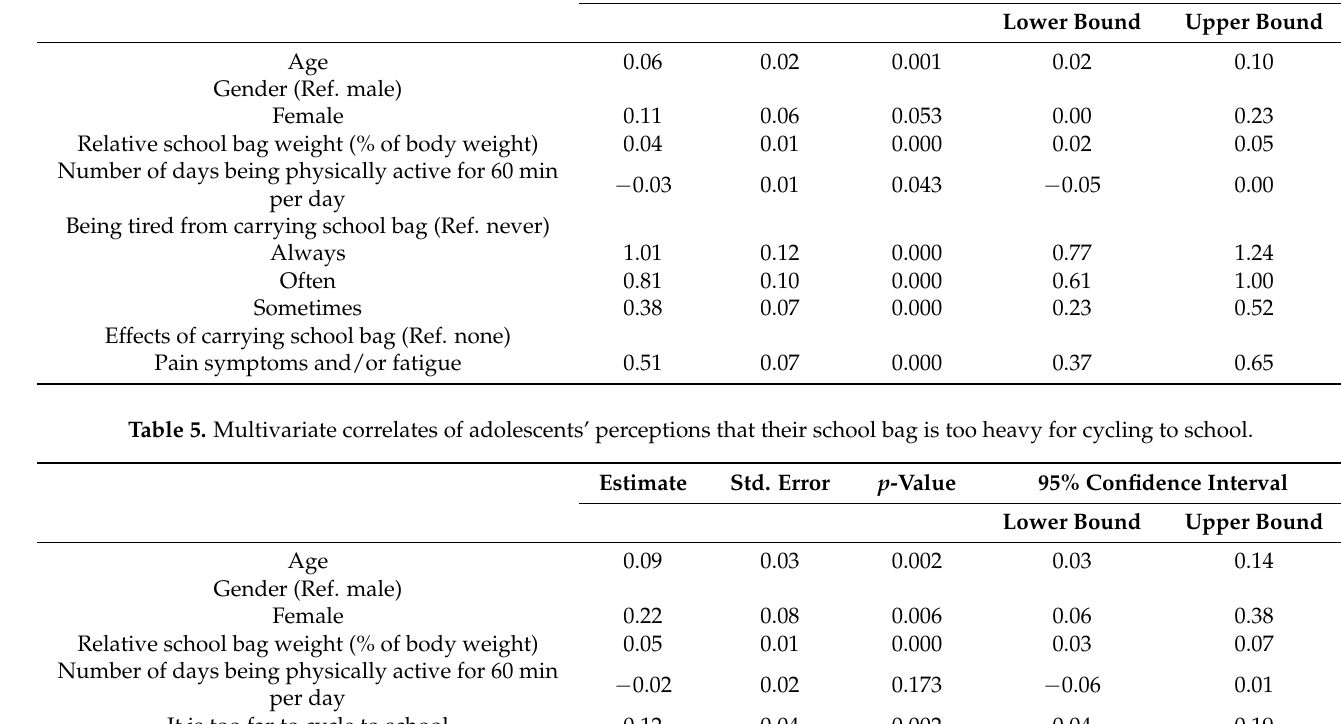
Table 4. Multivariate correlates of adolescents’ perceptions of excessive school bag weight for walking and cycling to school. Estimate